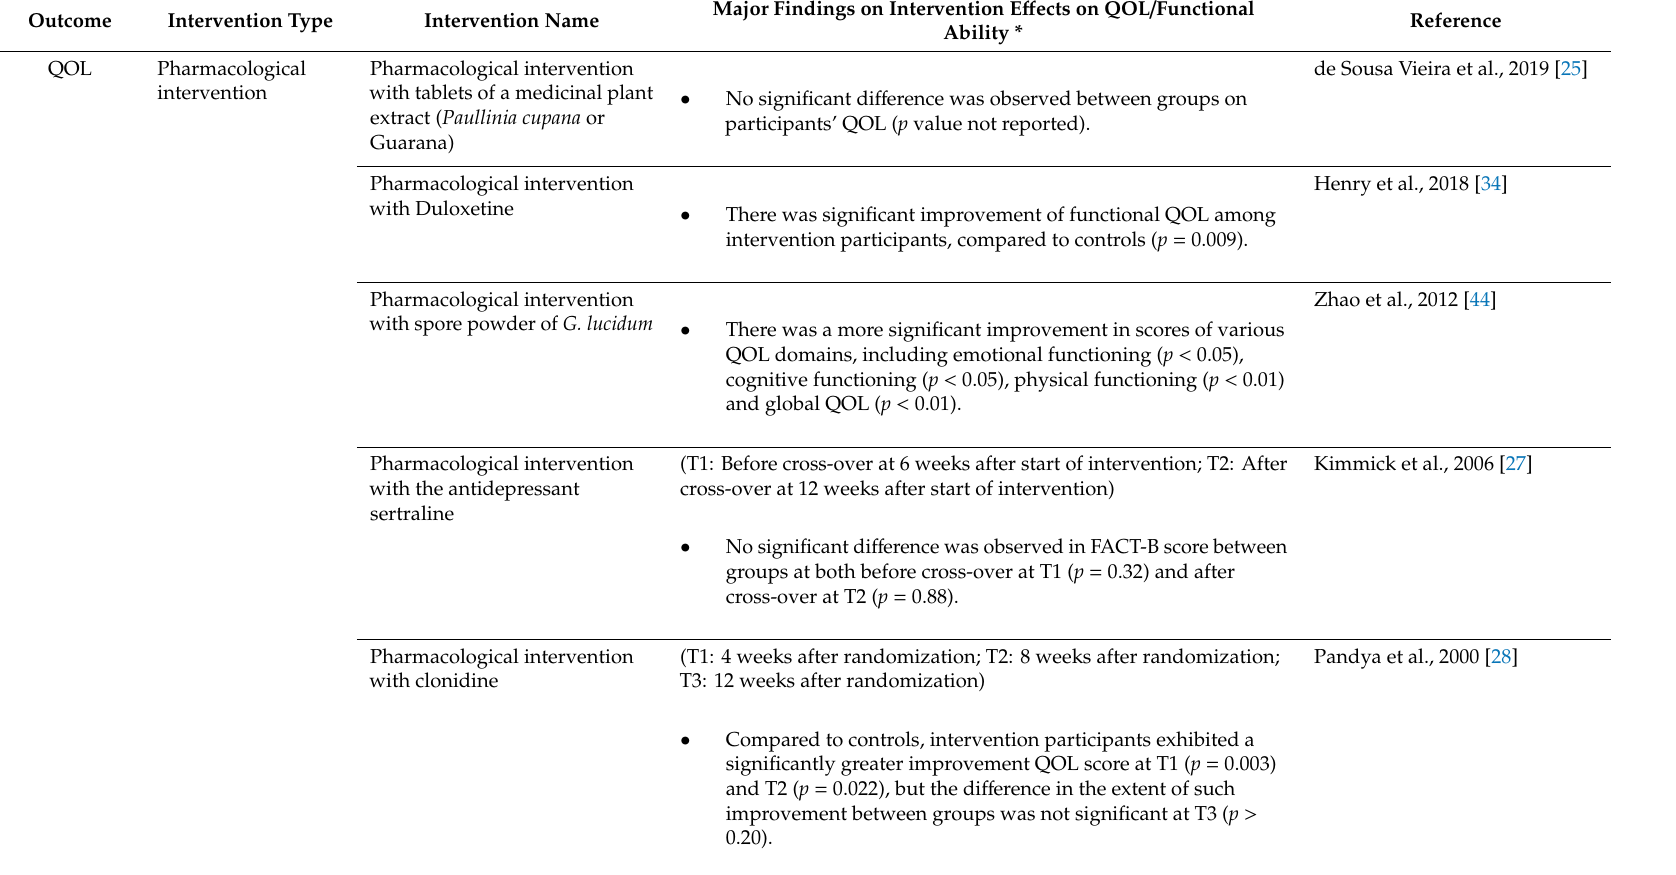
Table 8. A summary of the e ff ects of reported interventions on participants’ QOL and functional